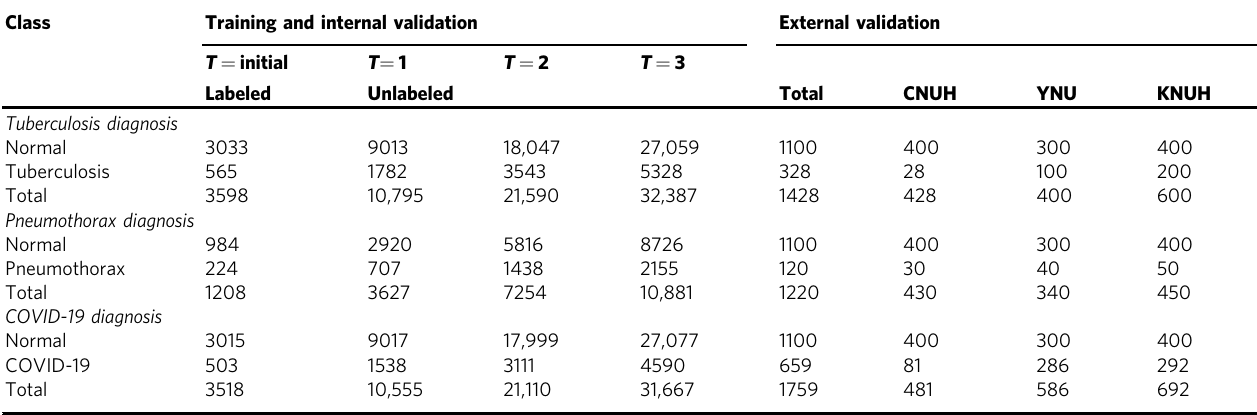
Table 1 Details of data partitioning used for the experiments of three chest X-ray (CXR) tasks.